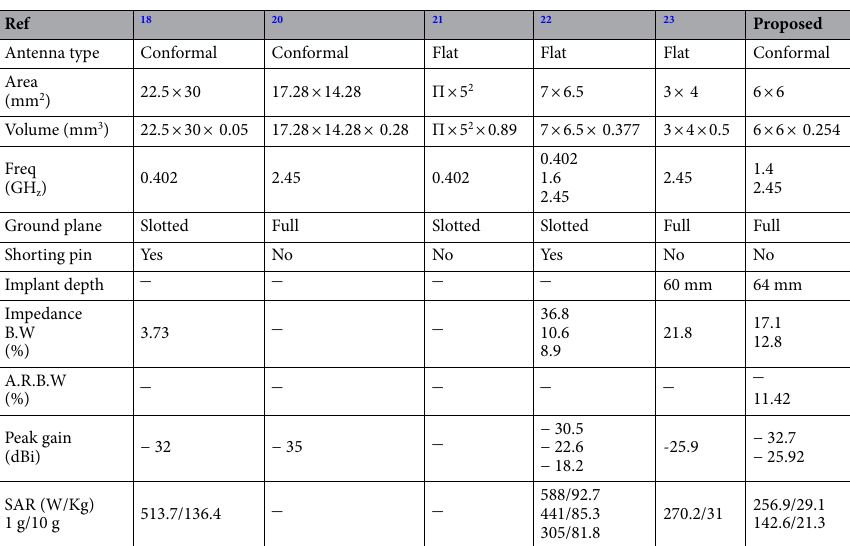
Table 1. Comparison of the proposed antenna with the other reported